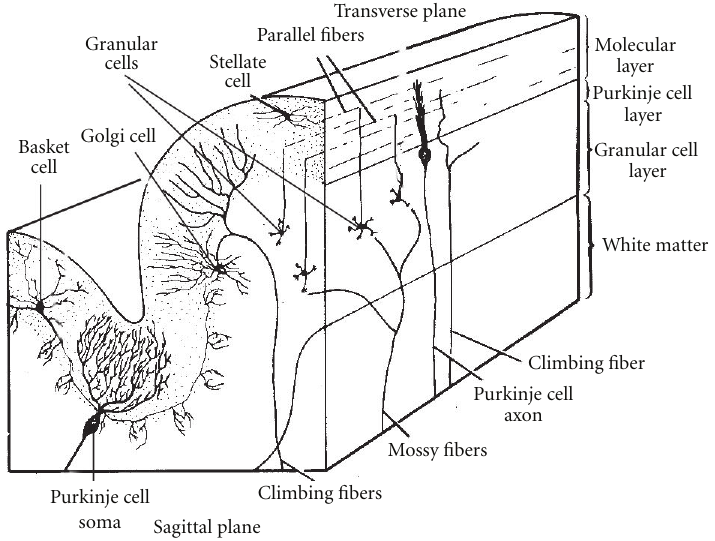
Figure 1: Organization of the mammalian cerebellar cortex in transverse and sagittal planes. Adapted from Brain Res 1981 [79].